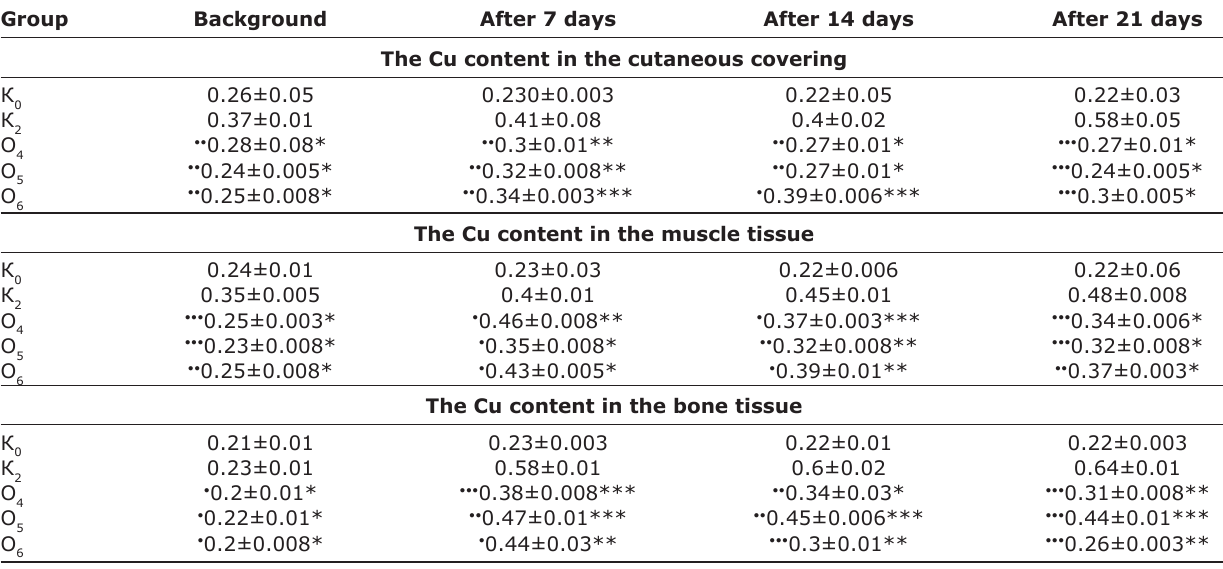
and K in the 0 2